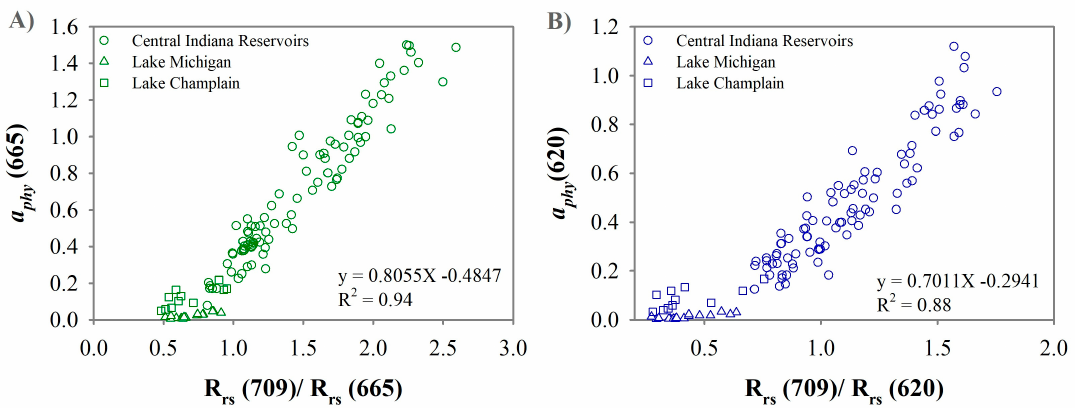
Figure 1. Linear relationship between a phy at 665 nm and R rs 709/665 ( a ), and between a phy at 620 nm and R rs 709/620 ( b ).